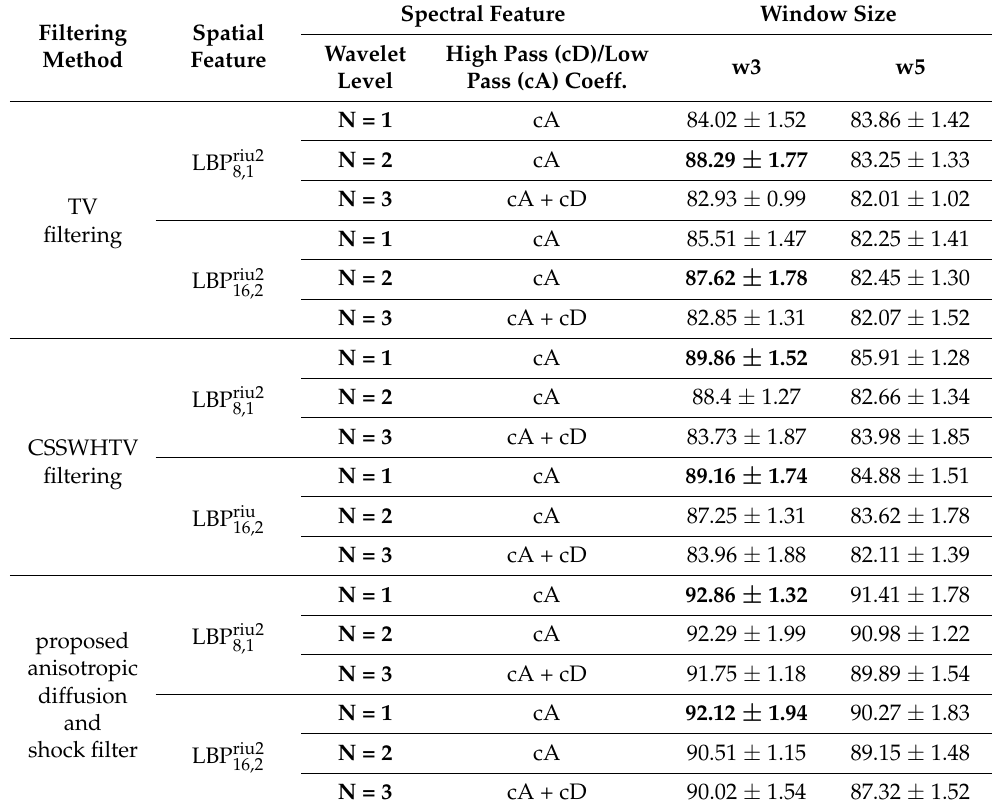
Table 8. Classification accuracy for the Pavia University dataset, using the TV, the CSSWHTV and the anisotropic diffusion and shock filter-based approaches, with wavelet transform for three levels, with the corresponding window size, of dimension 3 × 3 and 5 × 5, for the controlled sampling strategy and LBP histogram computation, w3 and w5